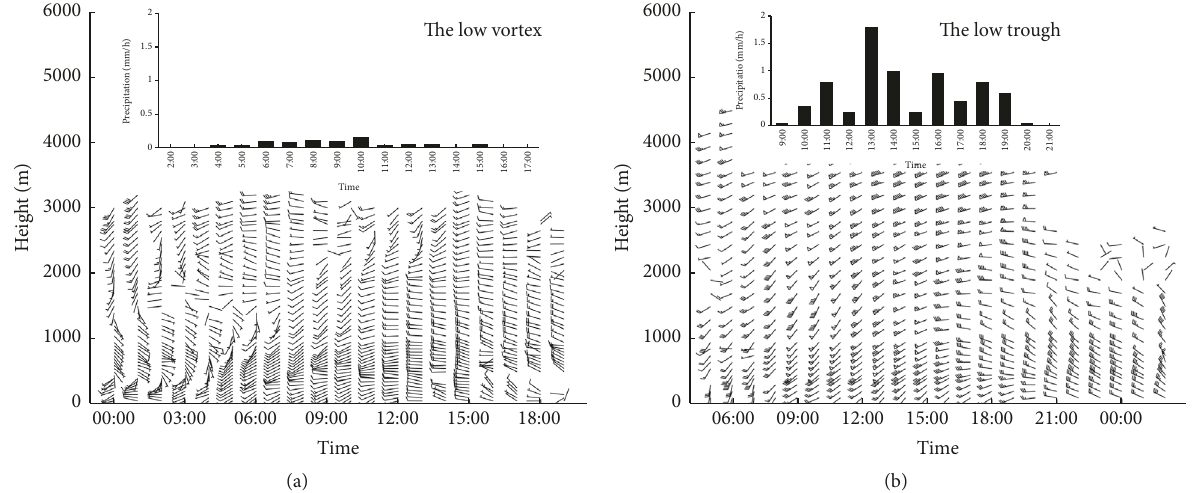
Figure 4: Evolution of wind and precipitation rate (black column) at Yan Jiaping under typical low vortex (case 9, (a)) and low trough (case 11, (b)) during snowfall. The height in 𝑦 -axis is above the ground.